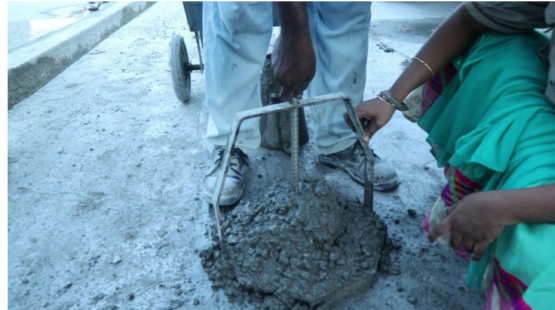
Figure 8. Measuring the slump value.